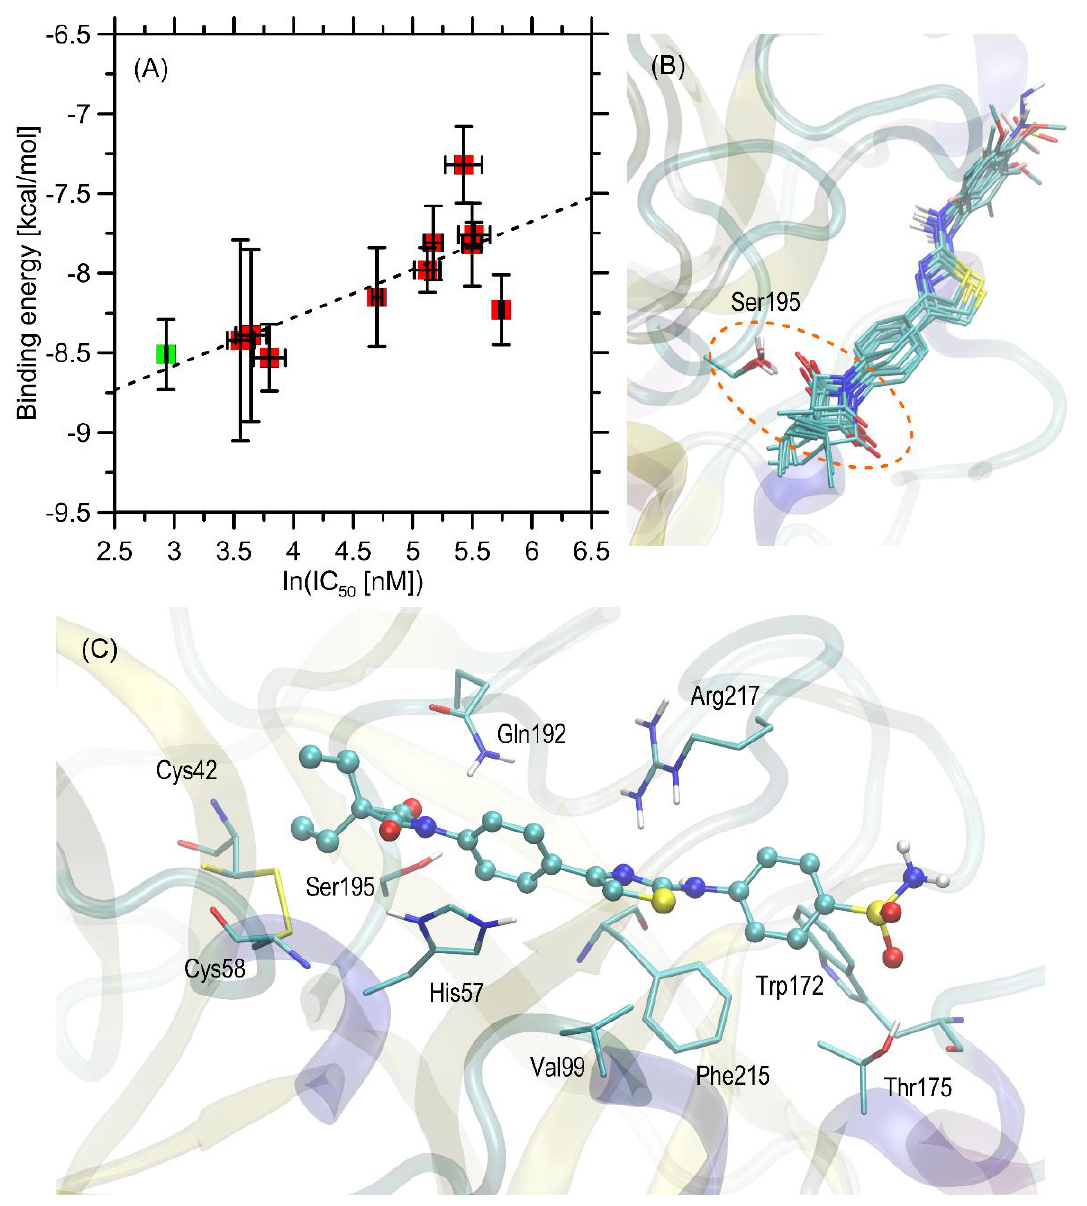
Figure 3. ( A ) The correlation between the calculated binding energies, averaged over the five elastase structures available in the PDB database, and the corresponding (experimental) values of IC 50 . The horizontal bars represent the standard deviation values within the set of binding energies. Green symbol corresponds to sivelestat whereas red ones correspond to the remaining compounds. ( B ) The superposed positions of all studied ligands (stick representation) in the binding cavity of the 1bma structure of elastase. All of these positions were identified as the optimal ones during the standard (non-covalent) docking procedure with additional conditions imposing the maximal distance of oxygen atoms at the azetidine-2,4-dione group and Ser195 as equal to 0.3 nm. ( C ) The location of the 3e ligand molecule bound to the 1bma structure of elastase and found in the docking procedure. The ligand molecule is shown in a ball-and-stick representation, whereas all the closest amino-acid residues are represented by sticks. The description of the interaction types is given in the text.